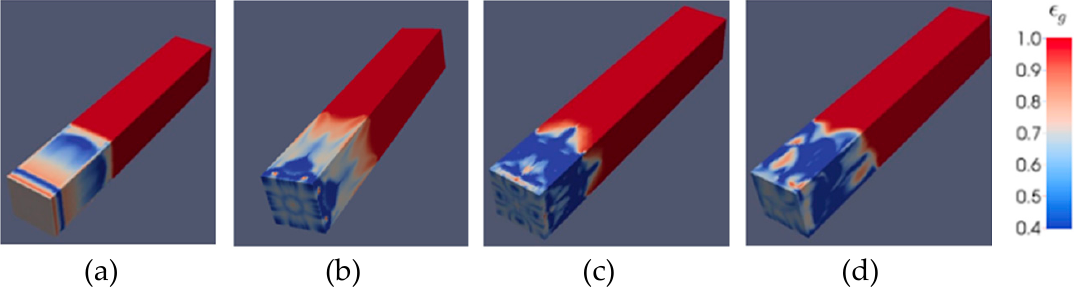
Figure 9. Gas volume fraction contours at different times encountered in the fluidized bed (for illustration purposes, the bed is titlted horizontally) ( a ) slug flow, ( b )maximum bed expansion, ( c ) bed collapse, and ( d ) fully fluidized bed